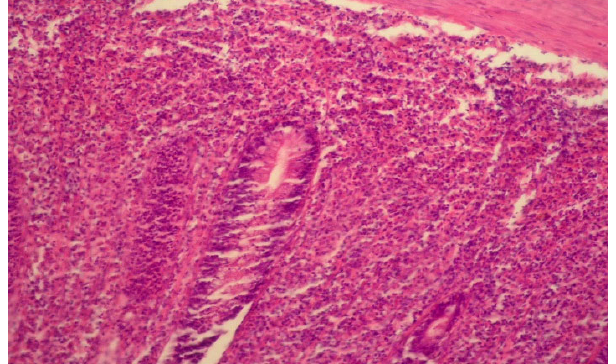
Fig. 3. Cellular infiltration of carp intestinal mucosa in Experiment 3. H&E. x 200